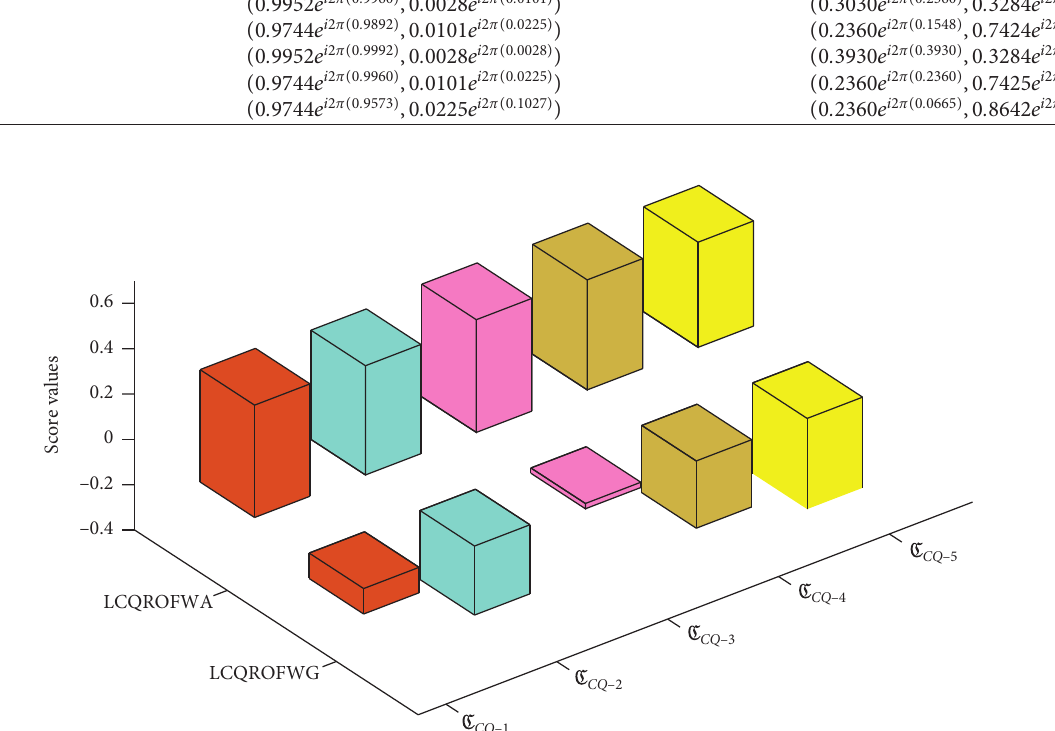
Figure 2: Geometrical representation of the score values of Example